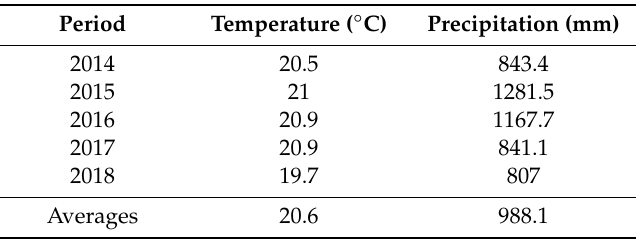
Table 2. Average annual temperature and accumulated annual precipitation in Viçosa-MG, from implantation to data collection of the